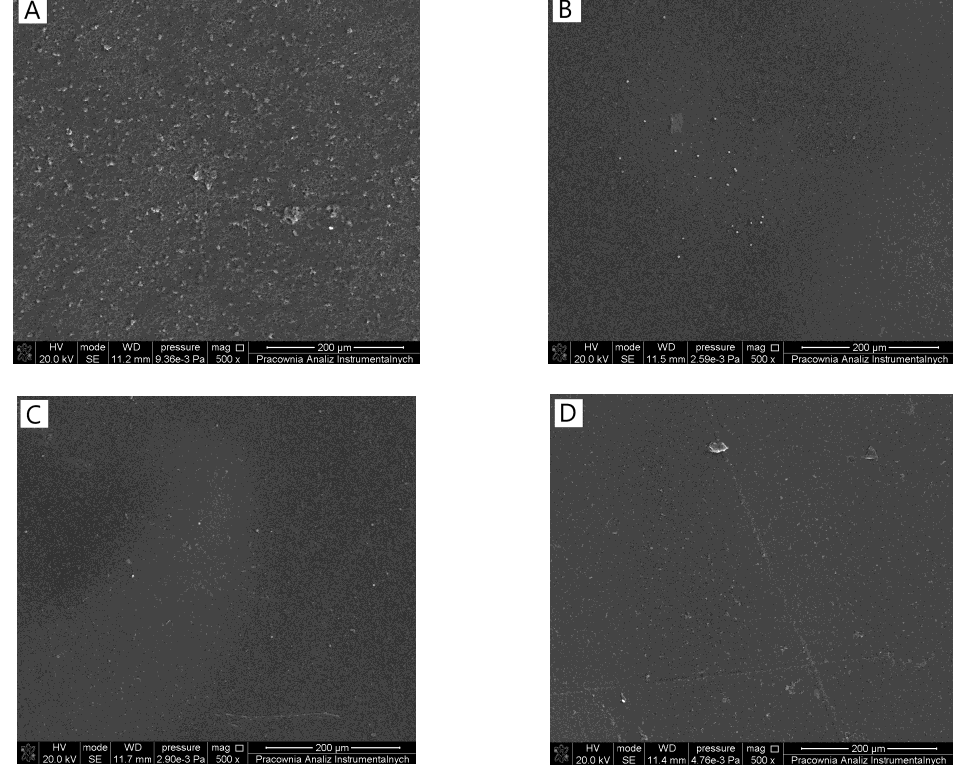
Figure 5. The morphology of the platelets adhered to the surface of ( A ) 100SA ( B ) 90SA/10TA ( C ) 80SA/20TA ( D ) 70SA/30TA (magnification: 1000×).